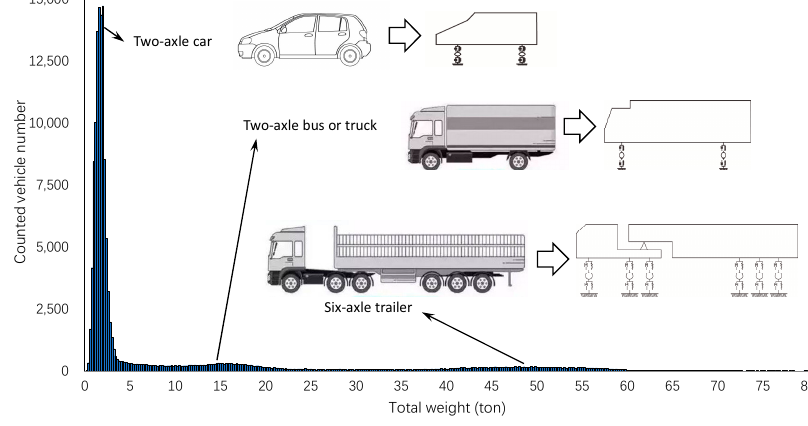
Figure 11. Vehicle weight distribution of ordinary